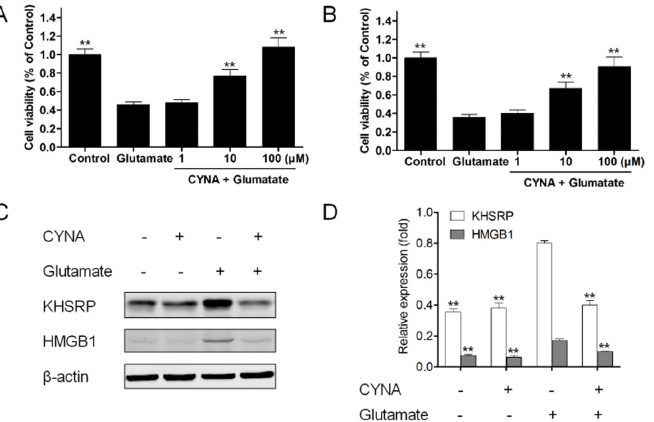
Fig 2. CYNA protected against glutamate-induced neurotoxicity in PC12 cells and cerebellar granule neurons. (A) Effects of CYNA on 5 mM glutamate-induced PC12 cell injury. (B) Effects of CYNA on 100 μ M glutamate-induced cerebellar granule neurons. Cells were treated with 1, 10, and 100 μ M CYNA and then co- incubated with or without glutamate for 24 h, and cell viability was determined by CCK8 assay. Data are presented as mean ± SEM (n = 6). ** P < 0.01 versus glutamate by one-way ANOVA analysis of variance with Tukey ’ s HSD post hoc test. (C) Proteins extracted from glutamate-treated cerebellar granule neurons either with or without pre-incubation with CYNA were subjected to western blotting to detect changes in KHSRP and HMGB1 expression. 10 μ M CYNA prevented the upregulation of KHSRP and HMGB1 after 100 μ M glutamate-treated. (D) Data shown are the results of three different experiments and are represented as the relative densities of protein bands normalized to β -actin. Results are presented as means ± SEM of three assays. ** Significant difference compared with glutamate by one-way ANOVA analysis of variance with Tukey ’ s HSD post hoc test ( P <